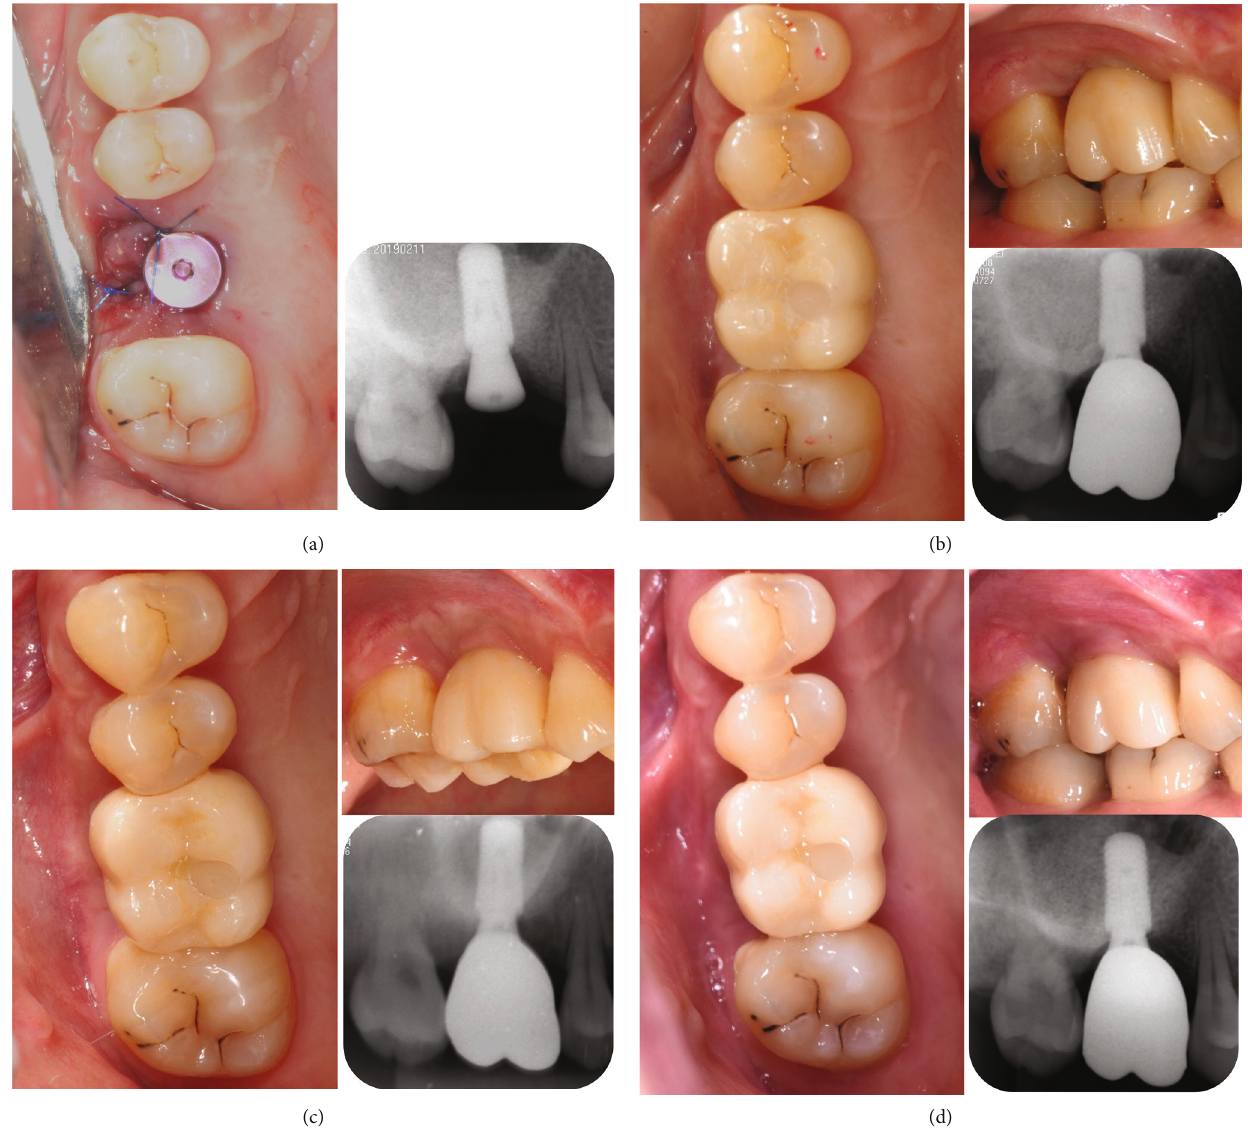
Figure 6: Periapical photographs follow-up for tooth #16. (a) Immediately after implant placement. (b) 5 months after implant placement. (c) 17 months after implant placement. (d) 26 months after implant